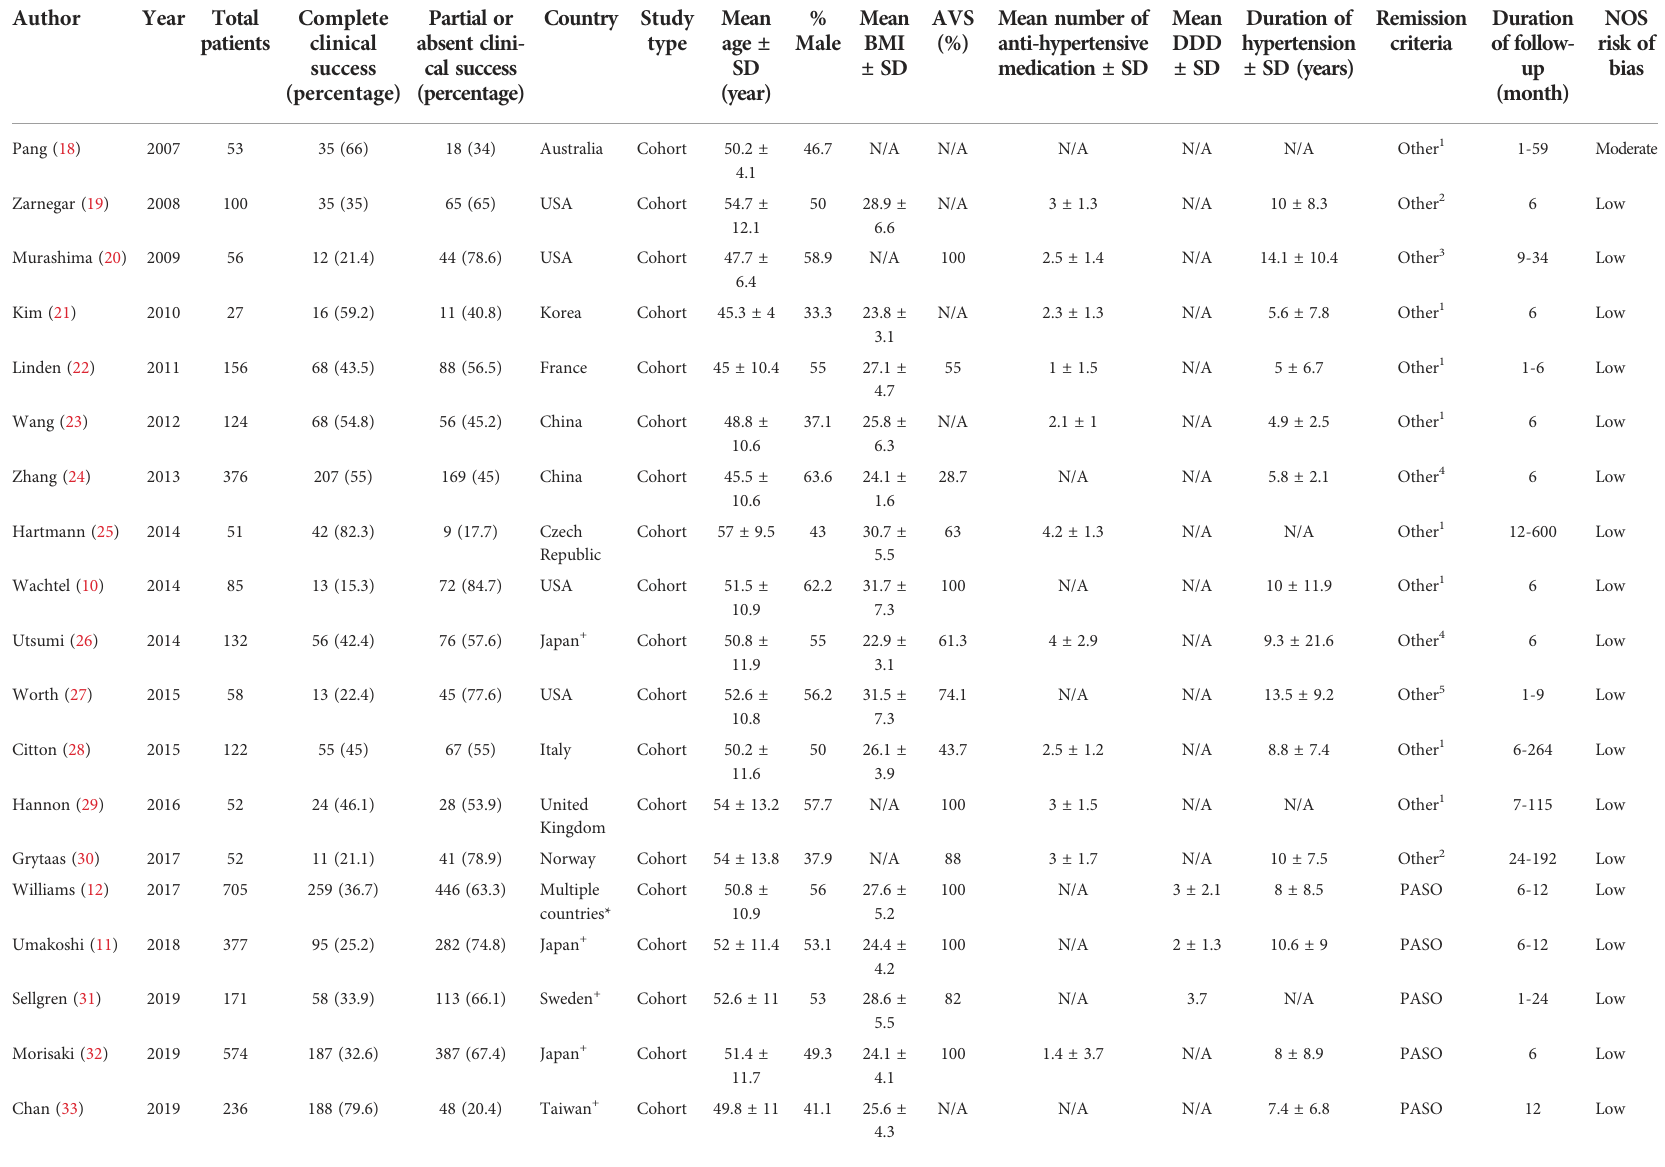
TABLE 1 Baseline characteristics of the 32 included